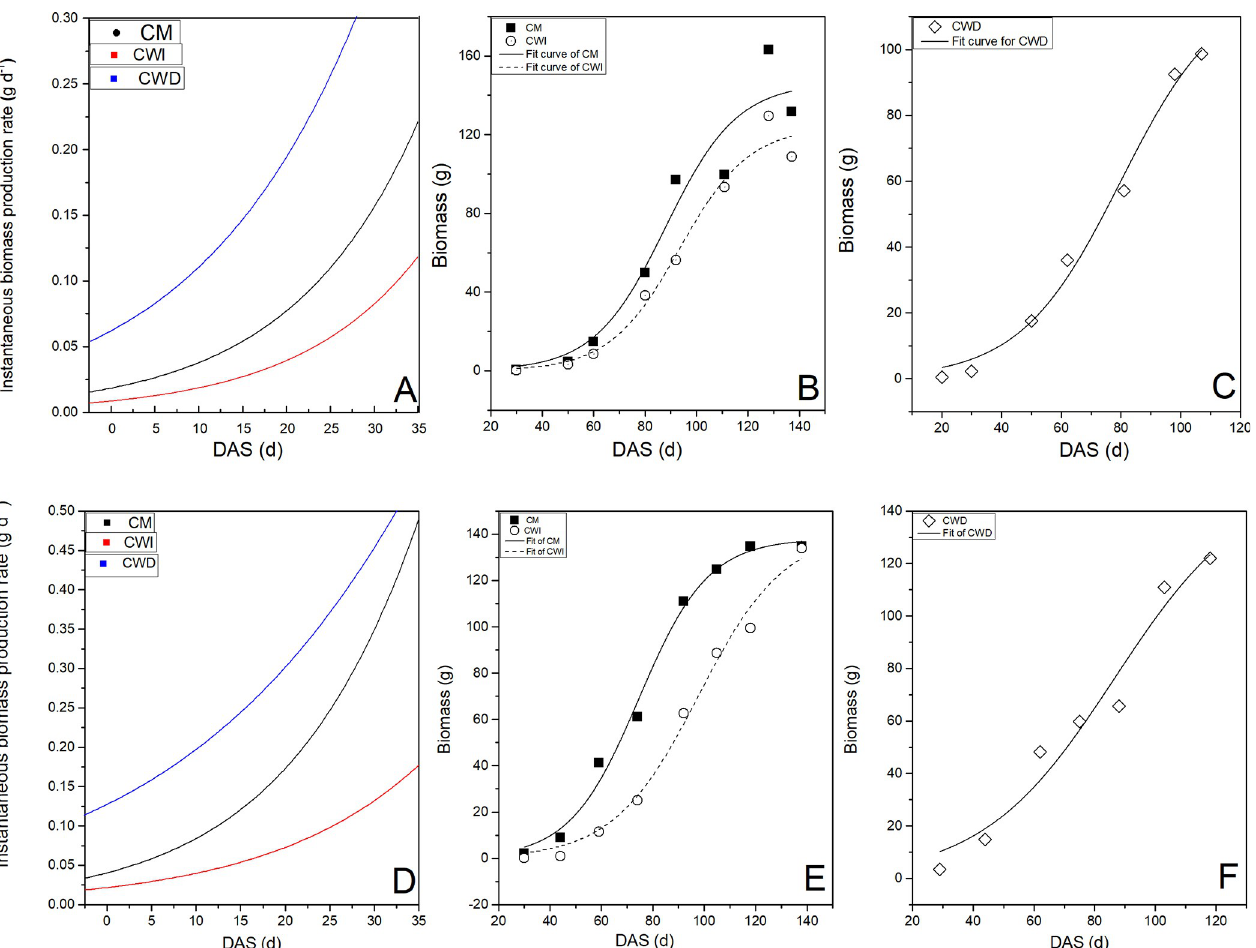
Fig 7. Sigmoidal fit of biomass accumulation and instantaneous biomass production rate for the different planting patterns in 2016 and 2017. Note: A, B and C represent the results of 2016; D, E, and F represent the results of 2017.